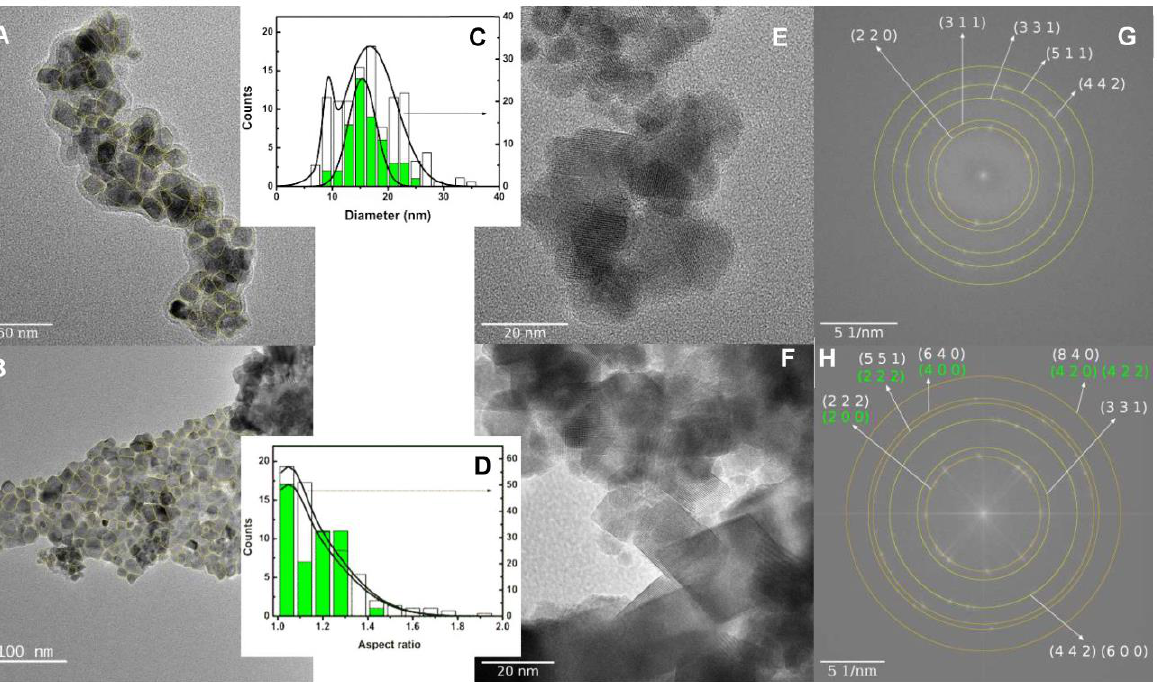
the size of the mixed ferrite nanoparticles is 15 ± 2 nm, which got enlarged upon the silver photodeposition process into 17 ± 5 nm. As the XRD results showed no significant size variation of the ferrite phase upon silver photodeposition, the increase seen here either corresponded to an enhanced nanoparticle aggregation or to an increase in size by silver coupling to the mixed ferrite nanoparticles. Nevertheless, the estimations of the size of the ferrite phase from TEM and XRD are compatible. There was also a noticeable appearance of a smaller size population (9.4 ± 0.9 nm) in the nanoparticles obtained by the silver pho- todeposition process. This was tentatively assigned to silver nanoparticles coupled with the ferrite surface, as observed in a previous study using a different silver deposition pro- cess [16]. Yet, the XRD size prediction of the silver phase was much higher (42.4 nm). This discrepancy could be due to the influence of a specific topology of the nanoparticles (silver on ferrite surface), as it was already observed in other metal coupled nanostructures, namely a gold diffraction peak width from a 2 nm shell equal to the one from a 10 nm magnetite core [38]. Using ImageJ software, it was possible to fit each outlined particle in a rectangle. Taking the ratio between the longer and smaller side, it resulted in an aspect ratio parameter that is represented in Figure 5D taking values mainly up to 1.4.